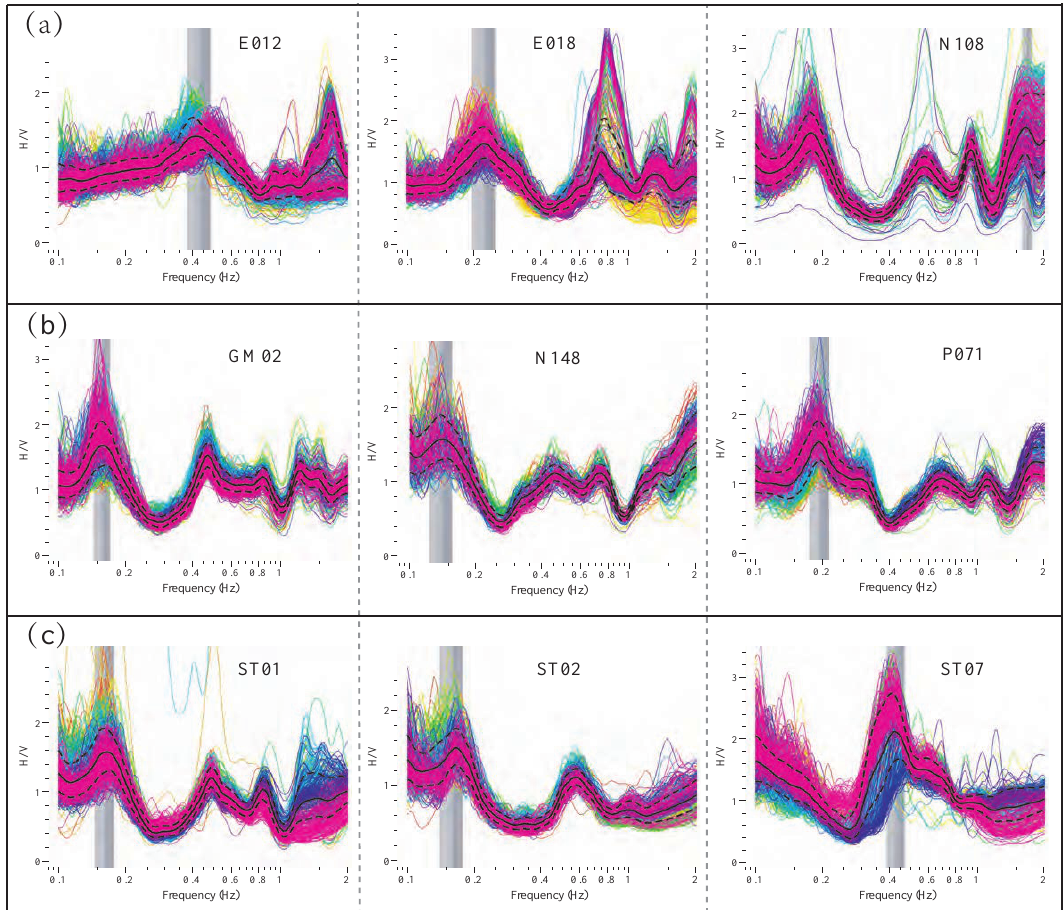
Figure 3. H / V spectra of nine stations shown as representative of all results in this study. Panel (a) , (b) and (c) are each comprised of three stations that belong to the TAMSEIS, GAMSEIS and POLENET/ANET arrays, respectively (the locations can be seen in profiles displayed in Fig. 4). The H / V spectra were calculated using five-day long ambient noise records. In each spectrum, the value at the limit between the two vertical grey areas is the peak frequency, while the two grey areas denote its standard deviation. The spectra of the E012, E018, GM01, N148, P071, ST01 and ST02 stations represent 42 stations, where the clear first peaks with the largest amplitudes are in agreement with the resonance frequency of the ice sheet layer. Station N108 is representative of 18 stations, where the first peaks are related to the ice sheet resonance frequency but with slightly lower amplitude than peaks in higher frequencies. ST07 is the example that where no correlation of the peak frequency with the ice thickness appears, as expected in the observed H / V